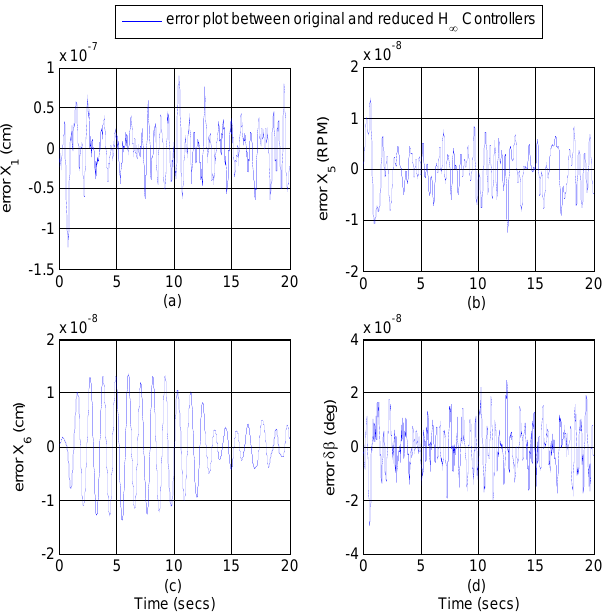
Figure 10. Error in transient responses of state variables (a-c) and controlled blade pitch angle (d) with original and reduced order H pertaining to wind disturbance input of 10.0*(rand(1,nstep))